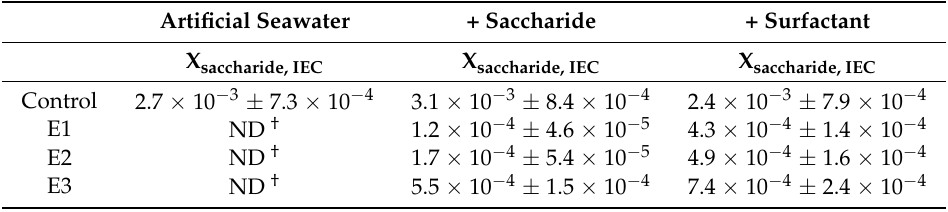
Table 3. Saccharide volume fractions (X saccharide, IEC ) with propagated absolute errors as determined by IEC and Equation (2) for SSA particles with diameters less than 250 nm for each addition of the MART